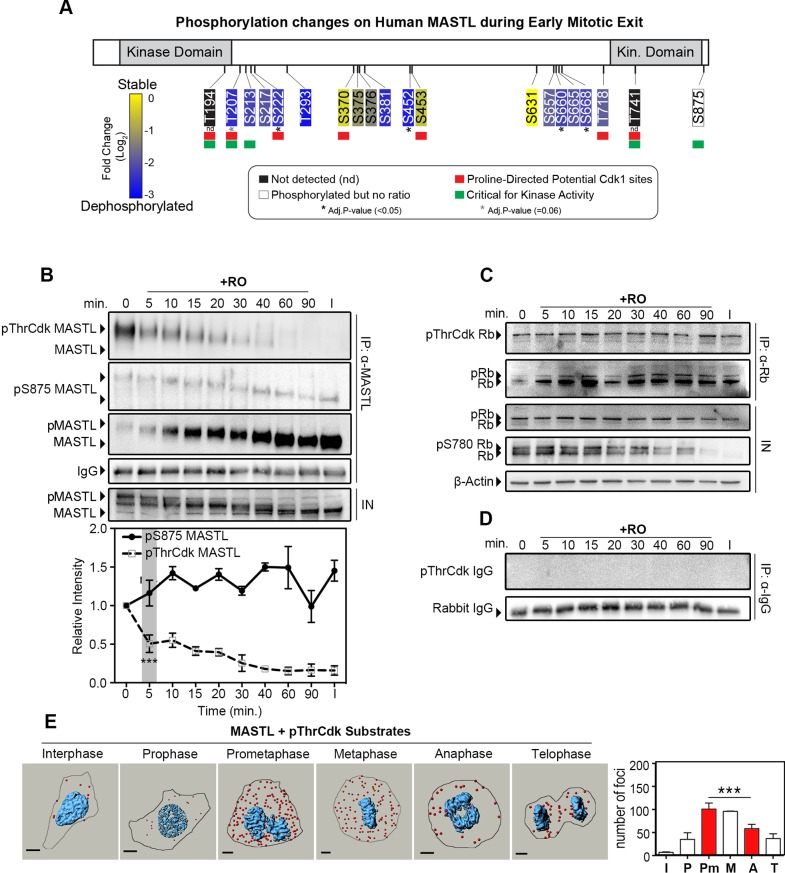
Cdk1 phosphorylation at threonine residues on MASTL are removed during early mitotic exit. (A) Summary of MASTL phosphorylation changes during early mitotic exit, as determined by SILAC mass spectrometry analysis. Sites crucial for kinase activity (green), proline-directed potential Cdk1 phosphorylation sites (red) and significantly dephosphorylated sites (*) are shown. Kin., kinase. (B) MASTL was immunoprecipitated (α-MASTL) from extracts as described in Fig. 1B, immunoblotted for total MASTL levels, pThrCdk substrates (pThrCdk MASTL) and MASTL that had been phosphorylated on Ser875 (pS875 MASTL). Quantification was performed, and the intensity is expressed relative to the protein level at 0 min, normalised to IgG loading. n=3; ***P<0.001; (one-way ANOVA). (C) Similar to the experiment shown in B, retinoblastoma protein (Rb) was immunoprecipitated (IP: α-Rb), and precipitates blotted for total Rb or pThrCdk substrates (pThrCdk Rb); total lysates were blotted for Rb phosphorylated on Ser780 (pS780 Rb) and β-actin (loading). (D) IgG precipitation (α-IgG) controls corresponding to B and C. (E) PLA using primary antibody pairs against MASTL and pThrCdk substrates. Red dots, interaction foci; blue, nuclei. Data are mean+s.e.m., for a minimum of five cells, n=2. Results in prometaphase and anaphase cells were compared (red bars); ***P<0.001 (two-way ANOVA). Scale bars: 10 μm. I, interphase; P, prophase; Pm, prometaphase; M, metaphase; A, anaphase; T, telophase.